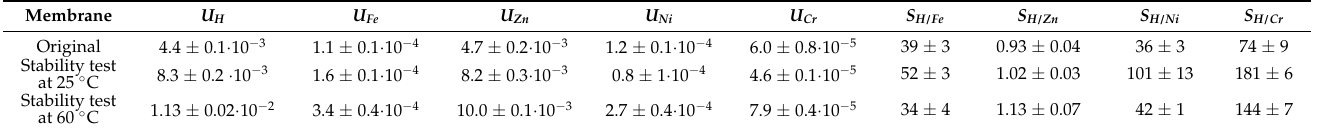
Figure 5. The HCl concentration in the dialysate chamber versus time during batch dialysis of feed solution for membranes (1) ( ∎ ) before use (initial state) and after stability tests in 25 °C (2) (•) and 60 °C (3) ( ▲ ) solutions. The concentration of metals in the dialysate chamber versus time during batch dialysis of the feed solution is given in the Supplementary Materials (Figure S1). Table 5. Batch tests’ dialysis coefficients ( U ) and separation factors ( S ).